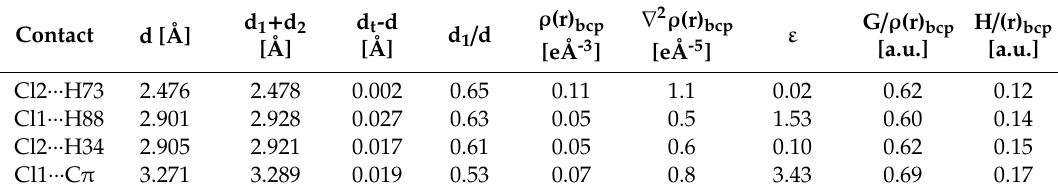
Table 2. Topological AIM properties of secondary interactions *.